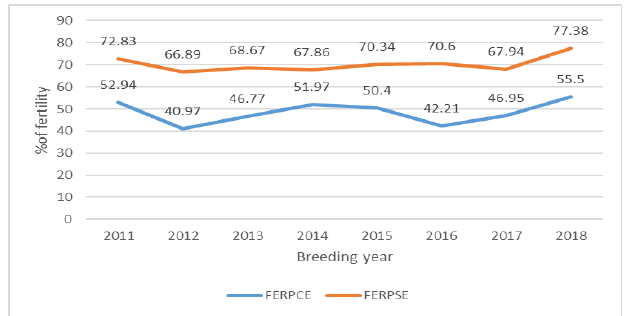
Figure 5. Variation of fertility according to the breeding year.